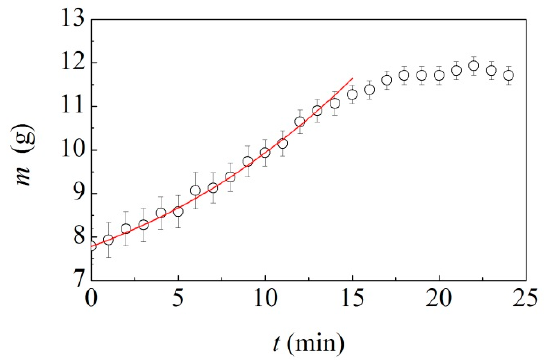
Figure 7. The kinetics of adhesion. The mass of the ball, m , as a function of time, t . Data have been averaged over three independent experiments. The best-fitted cubic curve is shown. The zero in the abscissa axis corresponds to the fifth minute of milling.